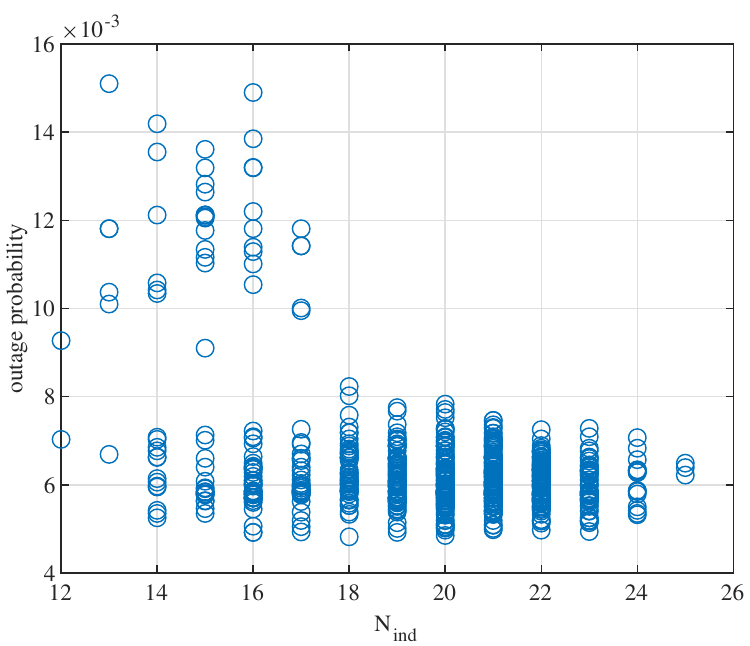
Figure 7. Scatter plot of 800 different random arrays showing the number of independent baselines in the linear array compared to its outage